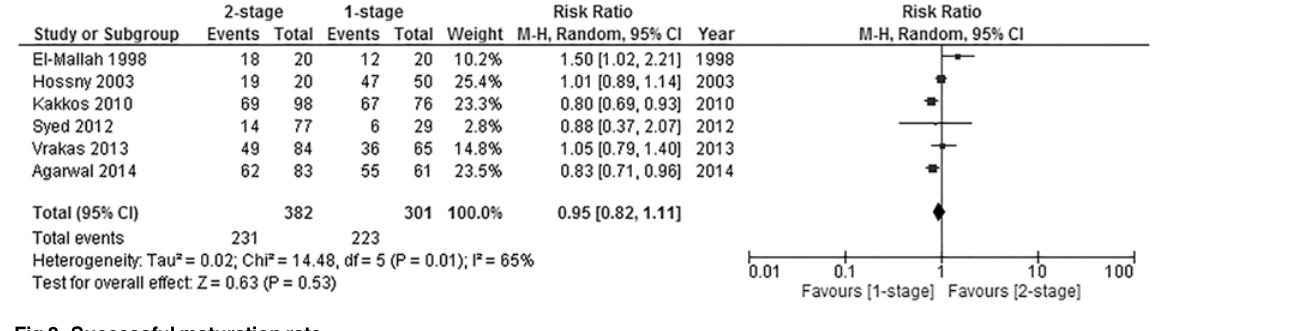
Fig 2. Successful maturation rate.